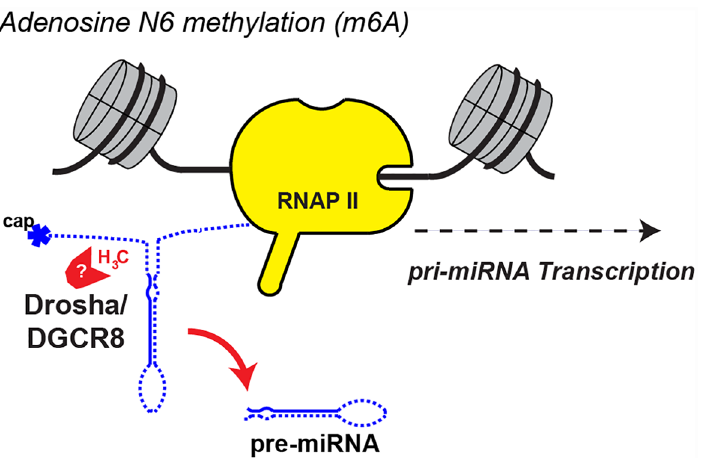
Fig 4. Model for how m6A may stimulate pri-miRNA processing. m6A is deposited on pri-miRNA by METTL3 and is thought to stimulate the recruitment of Drosha/DGCR8 for co-transcriptional processing of pri-miRNA to pre-miRNA [27]. The question mark is to highlight that the identity of the full set of m6A readers in pri-miRNAs is unknown. In yellow is shown RNAP II on DNA surrounded by